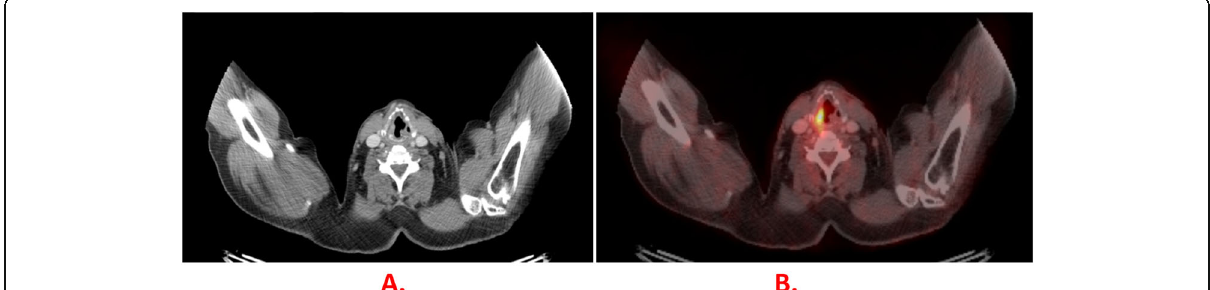
Fig. 1 A 67-year-old male patient, pathologically proven having NSCLC; the initial staging revealed the following: a CECT failed to detect clearly the left recurrent laryngeal nerve paralysis and invasion and b PET/CT showed high-grade metabolic activity at the right vocal cord due to paralysis of the left recurrent laryngeal nerve denoting its